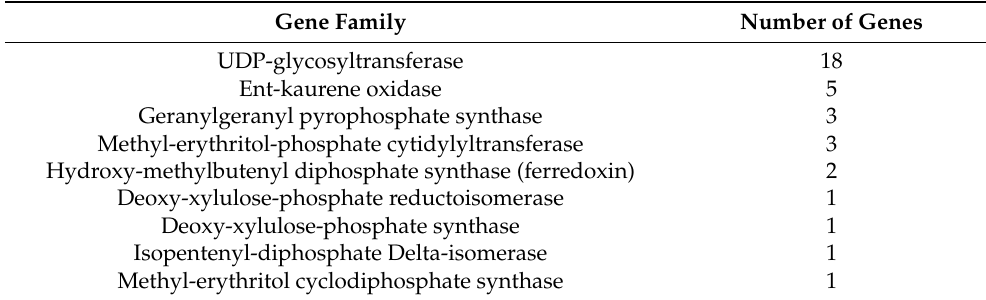
Table 1. Number of genes belonging to gene families involved in steviol glycoside metabolism found in proximity (within 100,000 bp upstream and downstream of each gene) of sequences complementary to ANG5+ IRAP primer. Gene Family Number of Genes UDP-glycosyltransferase 18 Ent-kaurene oxidase 5 Geranylgeranyl pyrophosphate synthase 3 Methyl-erythritol-phosphate cytidylyltransferase 3 Hydroxy-methylbutenyl diphosphate synthase (ferredoxin) 2 Deoxy-xylulose-phosphate reductoisomerase 1 Deoxy-xylulose-phosphate synthase 1 Isopentenyl-diphosphate Delta-isomerase 1 Methyl-erythritol cyclodiphosphate synthase